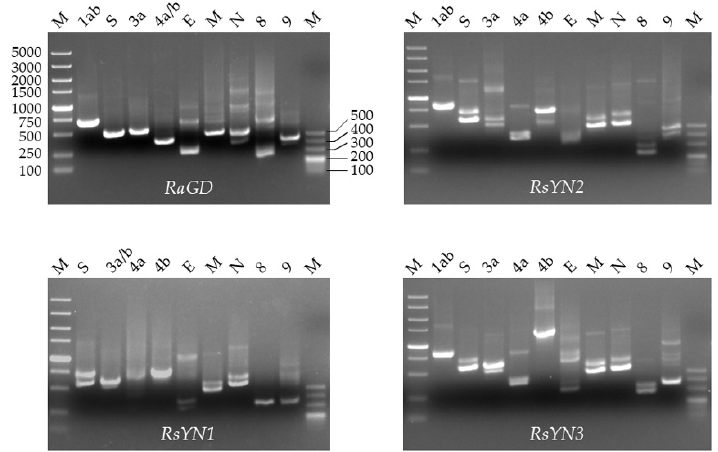
Figure 3. Subgenomic structure of 4 stains of BtCoV / Rh / YN2012. Agarose gel electrophoresis of the PCR products of subgenomic mRNA. The lowest band on each lane was the specific amplicon of each subgenomic mRNA. Other bands are amplicons of first-round PCR products or upper subgenomic mRNAs.